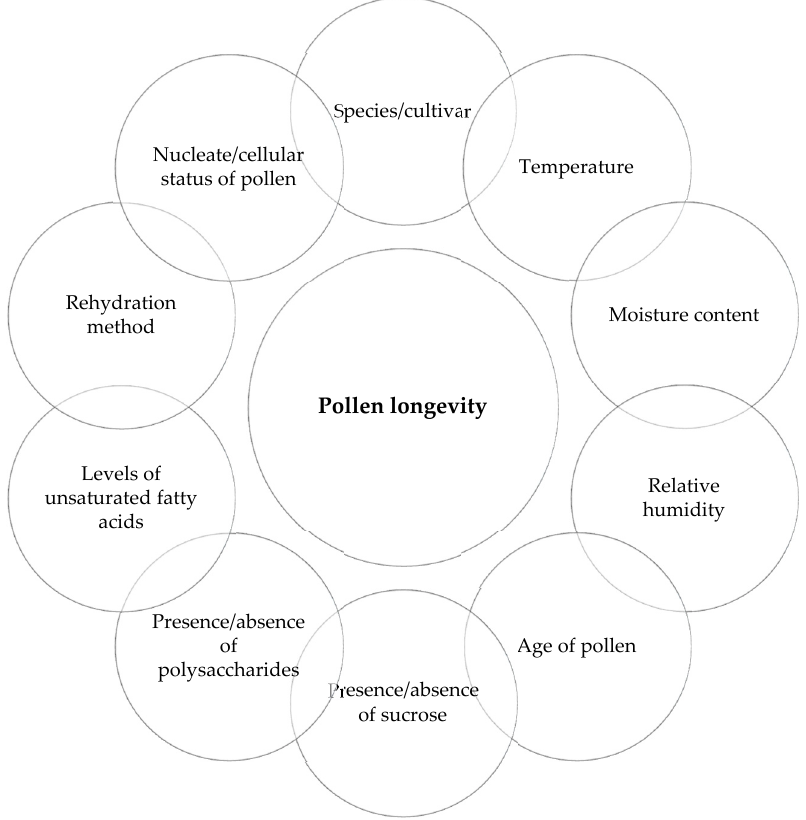
Figure 5. Factors affecting longevity of stored pollen. Figure 5. Factors a ff ecting longevity of stored